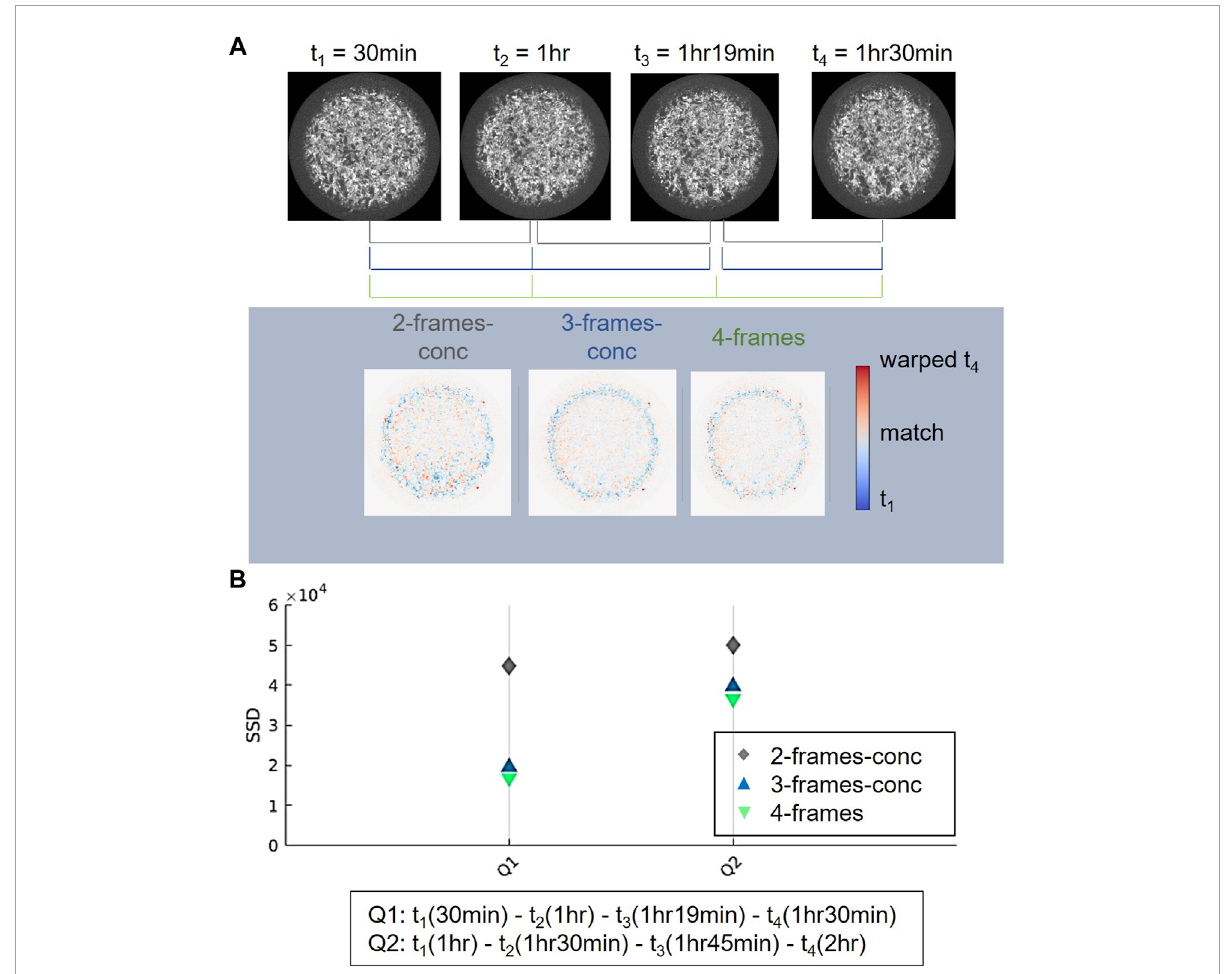
FIGURE 5 (A) Central slices of the consistency map defined as the difference between the reference (i.e., first frame of the temporal sequence) and deformed volumes (i.e., deformed last frame of the temporal sequence):blue regions correspond to material of t 1 does not match material in the warped t 4 ; red regions correspond to material of the warped t 4 does not match material in t 1 ; white regions correspond to material of warped t 4 that fully overlap material in t 1 . The first map is related to the 2-frames-conc method, the second is related to the 3-frames-conc method and the third is related to the 4-frames method. (B) Registration accuracy evaluated by SSD